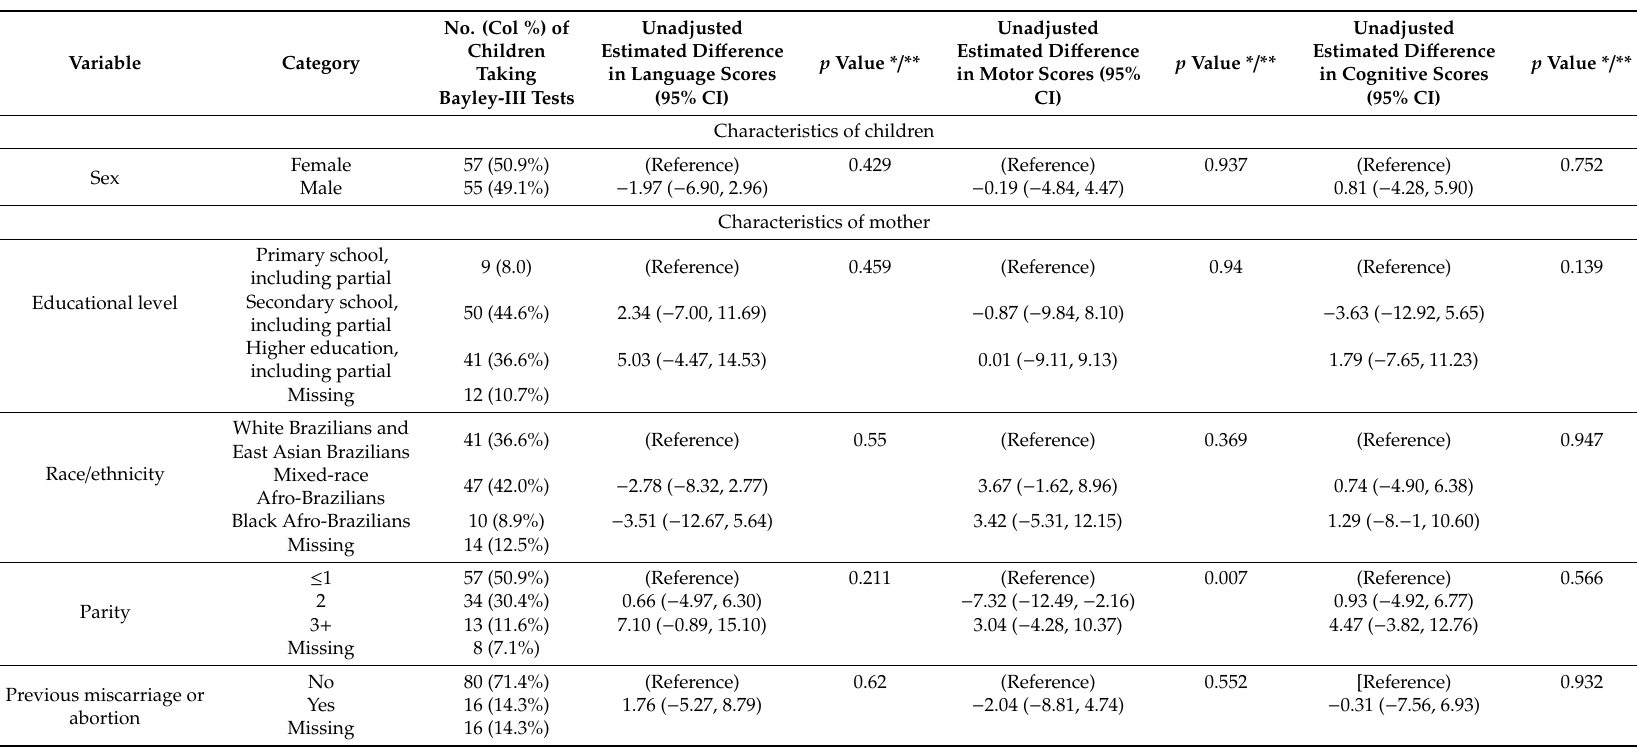
Table A3. Unadjusted estimated di ff erences in Bayley-III assessment scores according to risk factors, in the normocephalic study sample ( n =